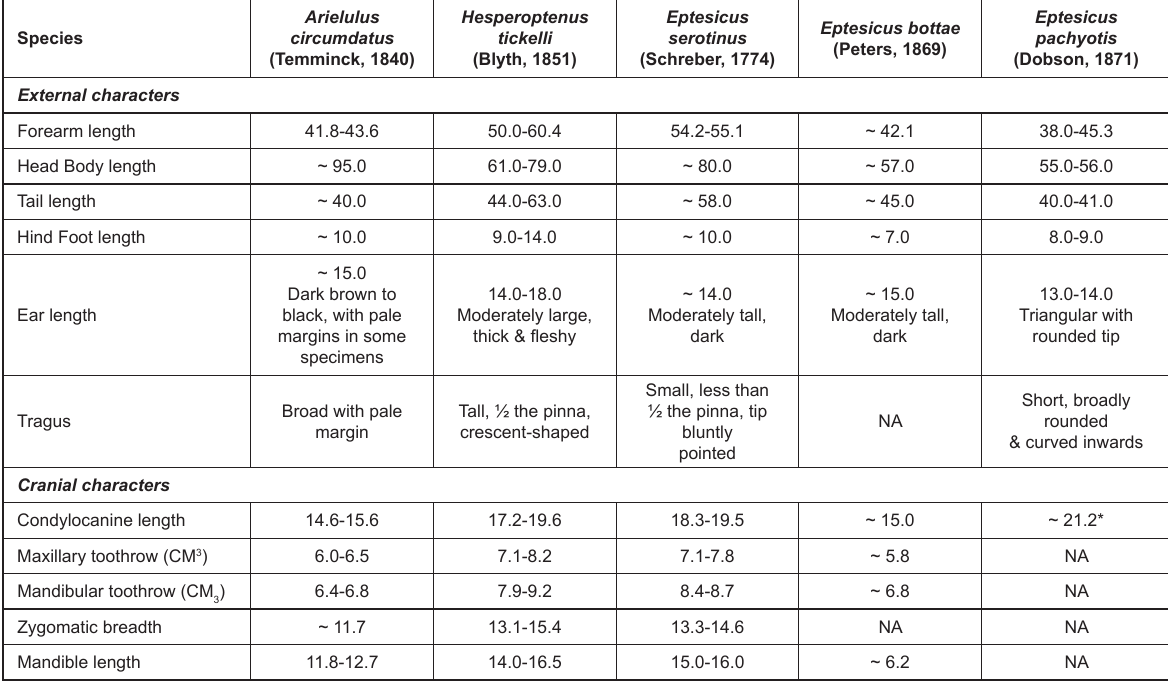
Table 7.6. Diagnostic morphological characters of the species belonging to the genus Arielulus , Hesperoptenus and Eptesicus present in South asia